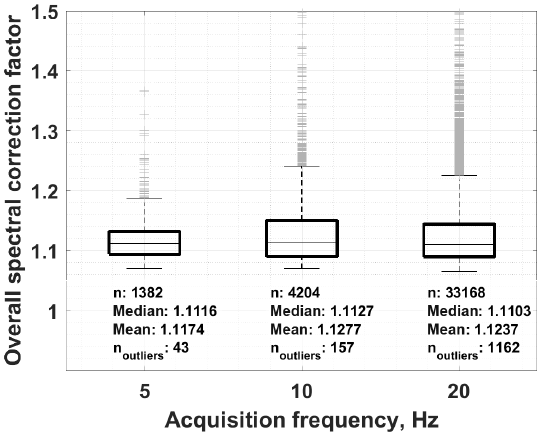
Figure 9. Spectral correction factor statistics for periods with dif- ferent acquisition